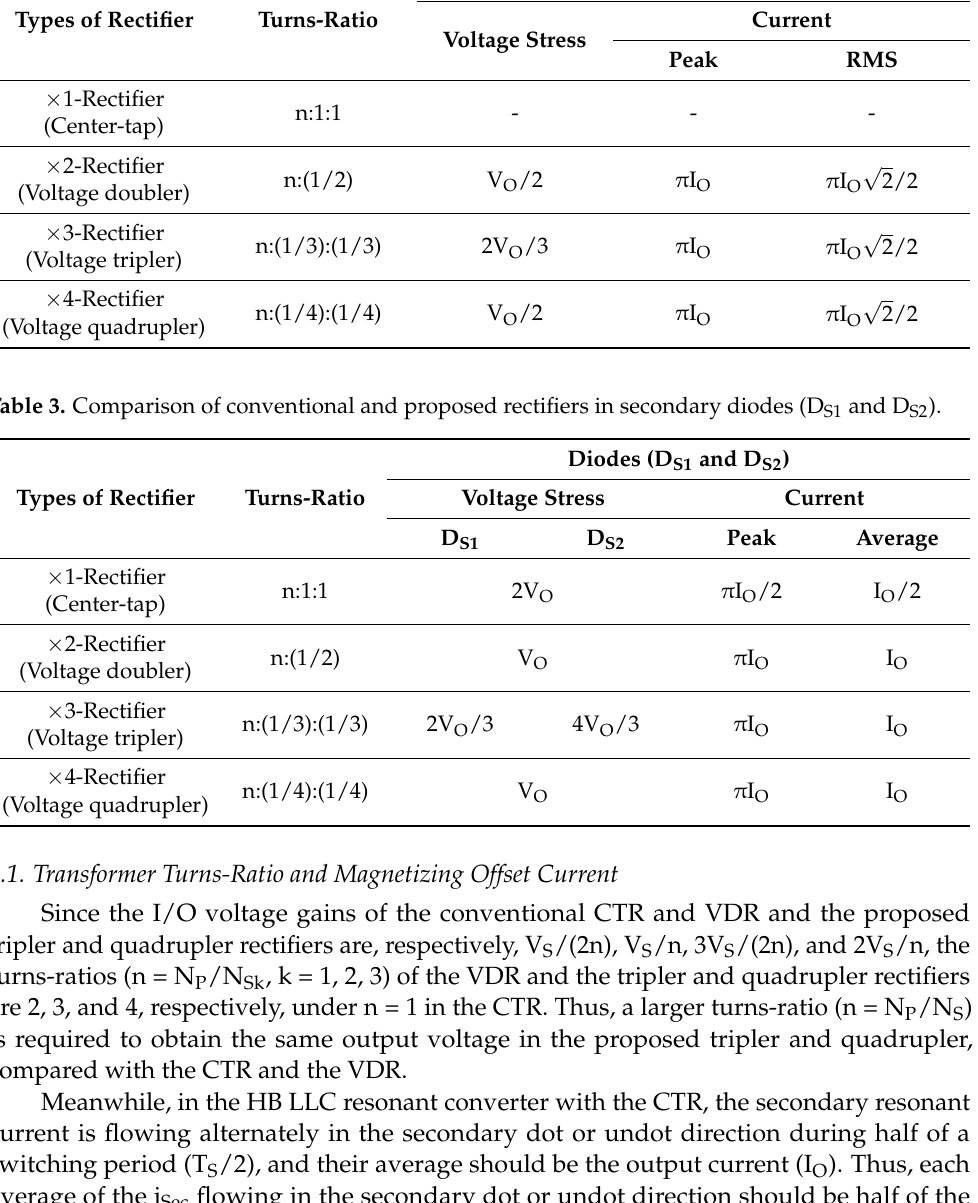
Table 2. Comparison of conventional and proposed rectifiers in turns-ratio (n) and secondary capacitor (C D ).